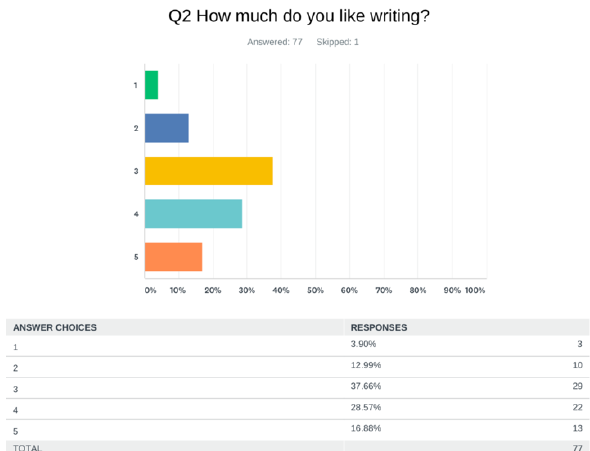
Figure 16 . Overall Summary, Question 2